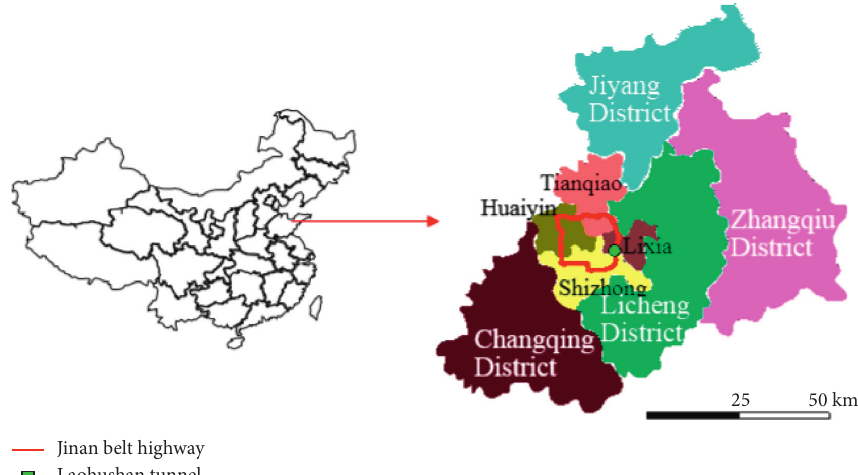
Figure 1: Location of Laohushan tunnel.